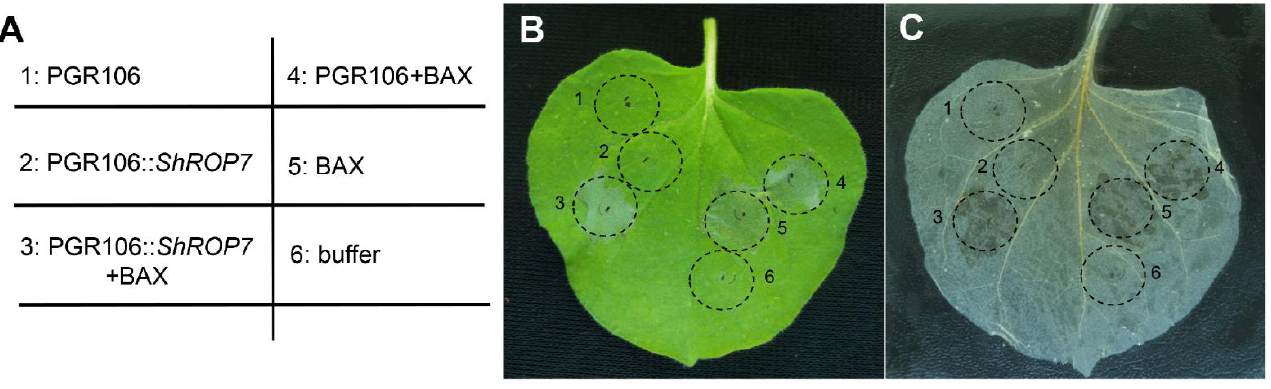
Figure 2. ShROP7 does not induce cell death in tobacco. ( A ) Injection diagram of Agrobacterium infected tobacco leaves. ( B ) Typical phenotype of tobacco leaves injected with Agrobacterium were photographed at 5 days post-infection. ( C ) The same leaf was decolorized with absolute ethanol and glacial acetic acid (1:1). 1: PGR106, 2: PGR106:: ShROP7 , 3: PGR106:: ShROP7 +BAX, 4: